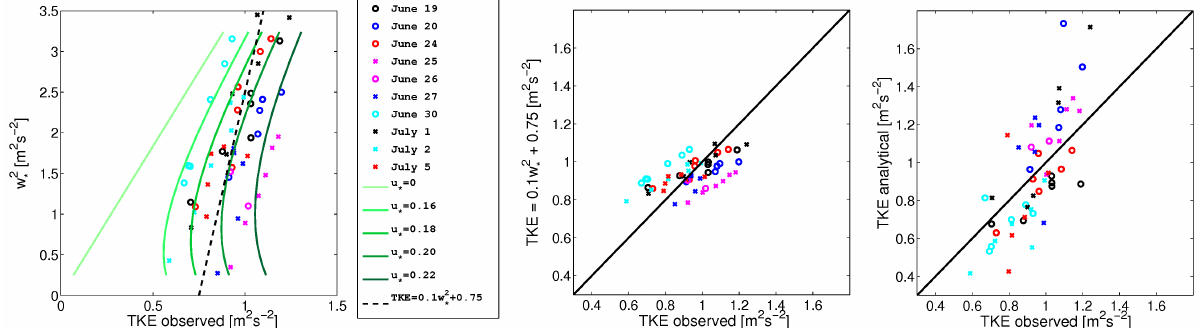
Figure 14. Left: observed w 2 ∗ as a function of observed TKE using hourly afternoon data. Here, Eq. (20) is illustrated with green colored lines for five different values of u ∗ and z i = 750m. A dashed black line is also shown as a fit to all the data. The hourly data have been assigned different colored symbols for different days as described in the legend and the same symbols are used in the middle and right panels. Middle: TKE calculated from the simple linear fit plotted as a function of the observed TKE. Right panel: TKE estimated from Eq. (20) plotted against observed TKE. Here, the observed u ∗ , z i and w ∗ values have been used together with Eq.